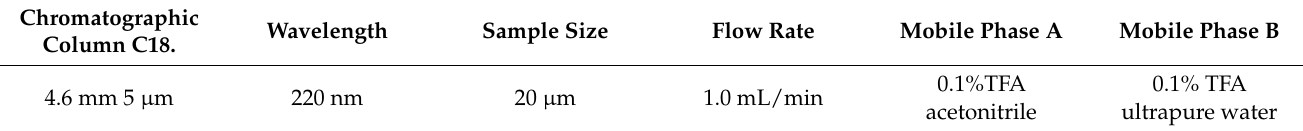
Table 1. Chromatographic conditions.